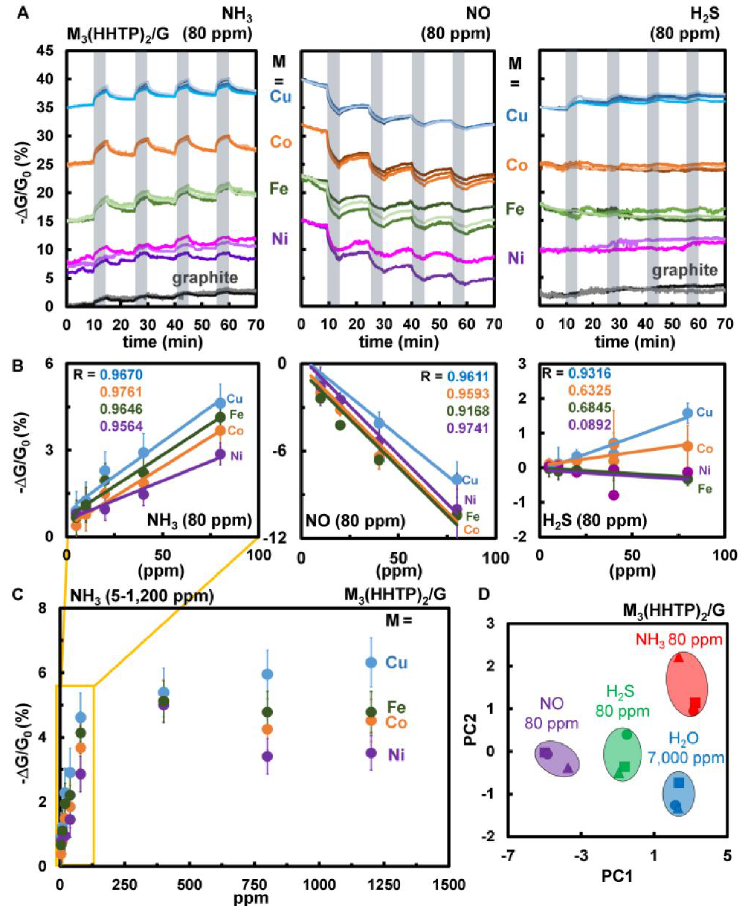
Figure 9. Sensing performances of M 3 HHTP 2 /graphite composites. (( A ) Change in conductance ΔG/G0 (%) over time (min) for the M 3 HHTP 2 /graphite blends (Fe 3 HHTP 2 = green, Co 3 HHTP 2 = orange, Ni 3 HHTP 2 = purple, Cu 3 HHTP 2 = blue). ( B ) Concentration dependence plots of sensing response of the M 3 HHTP 2 /graphite blends to NH 3 , NO and H 2 S (5 – 80 ppm). ( C ) Sensing performance of M 3 HHTP 2 /graphite array towards different NH 3 concentrations (1200, 800, 80, 40, 20, 10, 5 ppm) diluted with N 2 . (D) Ability of the array to distinguish between 80 ppm NH 3 , H 2 S, NO, and 7000 ppm H 2 ). Reproduced from Ref. [181].